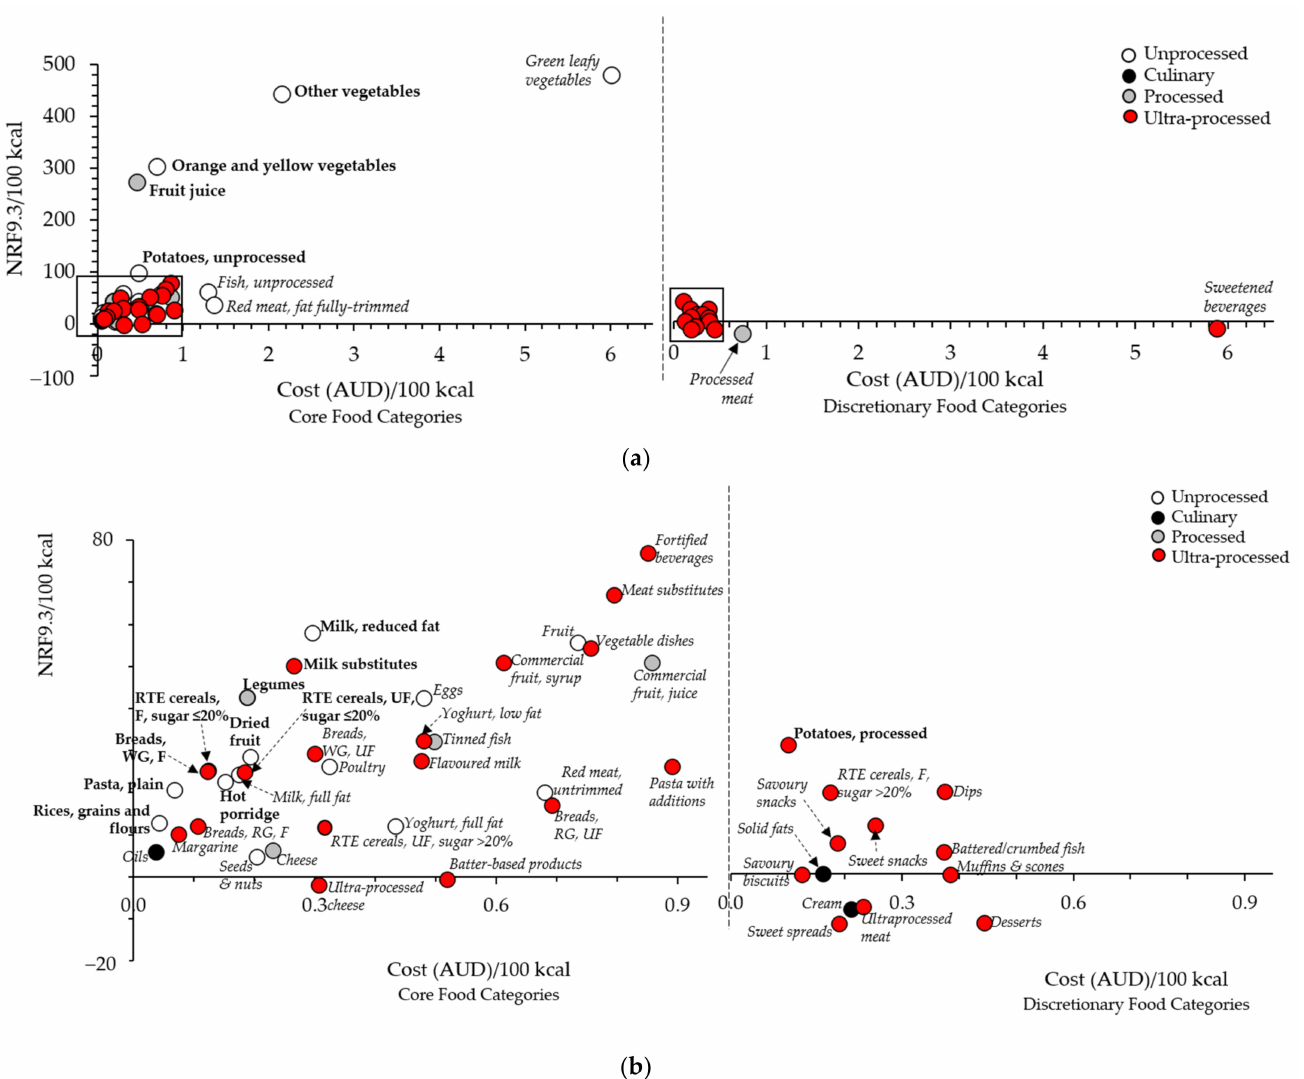
Figure 1. Nutrient density (NRF9.3) per 100 kcal vs. cost (AUD per 100 kcal) for the 57 food categories. ( a ) Full graph illus- trating the relationship between nutrient density and cost for all 57 food categories, separated as core or discretionary food categories. The majority of food categories are clustered with an NRF9.3/100 kcal less than 80 and a cost (AUD)/100 kcal) less than AUD 0.9 (boxed areas). The food categories in the highest quartile of the nutrient density-to-cost ratio are shown in bold, food categories in Quartiles 2–4 are in italics; ( b ) enlargement of the clustered food categories contained within the boxes in Figure 1a for each core and discretionary food category. The food categories appearing in the highest quartile of the nutrient density-to-cost ratio are shown in bold, and food categories in Quartiles 2–4 are in italics. Figure abbreviations: F, fortified; RTE, ready to eat; RG, refined grain; UF, unfortified; WG,